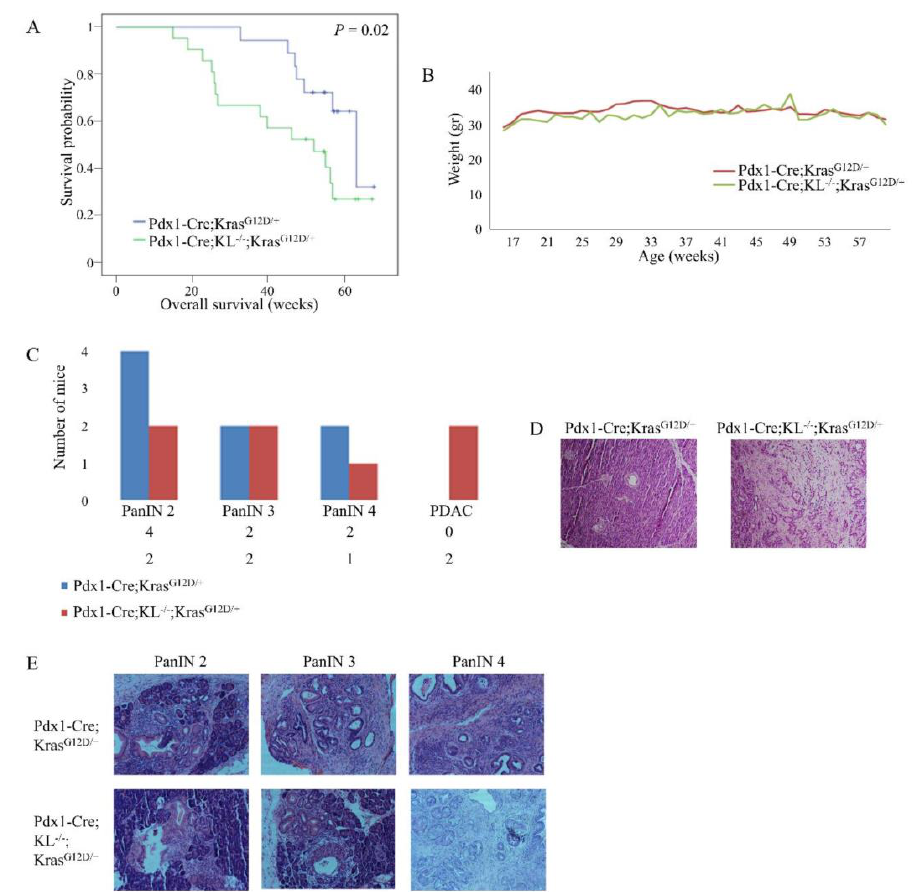
Figure 4. Pancreatic KLOTHO knockdown contributes to reduced survival and induces PDAC in vivo. ( A ) Kaplan-Meier curves of Pdx1-Cre; KL − / − ; Kras G12D/+ ( n = 21) compared to control Pdx1-Cre; Kras G12D/+ ( n = 18) mice. p = 0.02. ( B ) Weight of mice in both groups ( n = 19 per group). ( C – E ) Pancreata were excised from Pdx1-Cre; KL − / − ; Kras G12D/+ ( n = 7, average age 36 weeks) and control Pdx1-Cre; Kras G12D/+ ( n = 8, average age 49 weeks) mice upon sacrifice. ( C ) Comparison between pathological assessment of H&E stained pancreata of both groups. ( D ) Representative H&E staining of pancreata harvested from 24-week-old mice. Pdx1-Cre; KL − / − ; Kras G12D/+ (right): complete loss of cellular polar- ity, significant nuclear atypia, and budding of cell clusters into the ductal lumen, along with profuse fibrosis and keratin. Control Pdx1-Cre; Kras G12D/+ (left): no lesions. Magnification: ×10. ( E ) Repre- sentative PanIN lesions of both groups. Magnification: ×10.